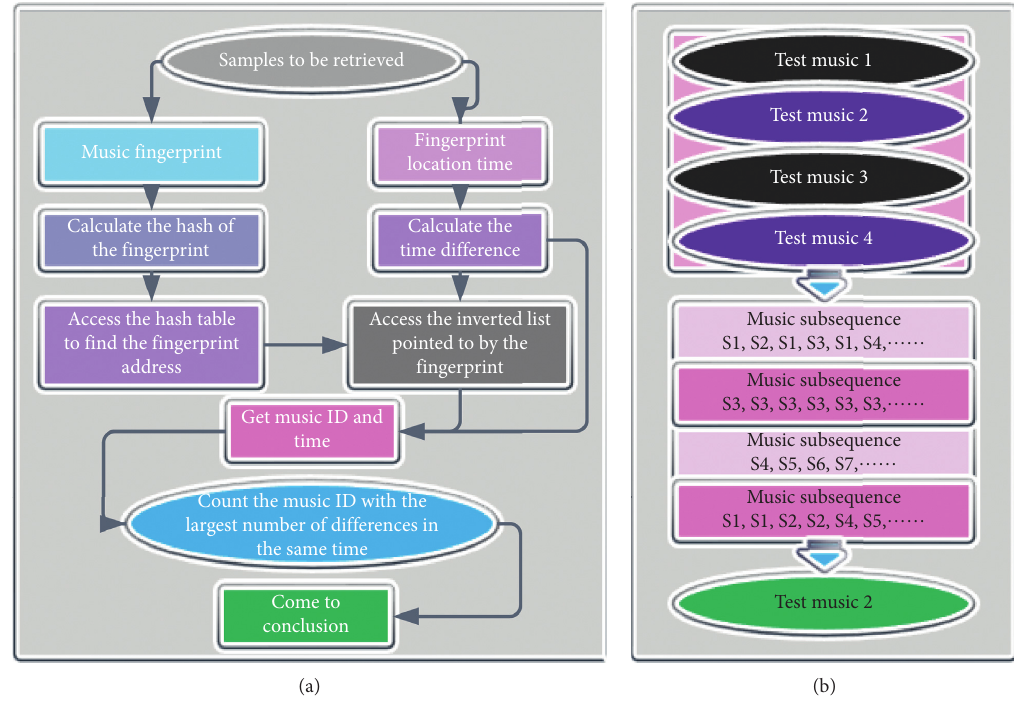
Figure 2: Music subsequence matching and similarity